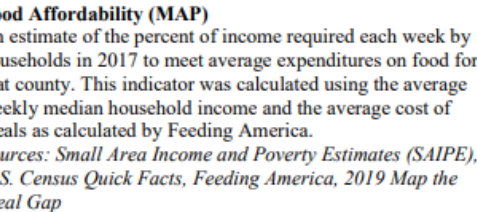
Figure 2. Food Affordability Map (“Need”